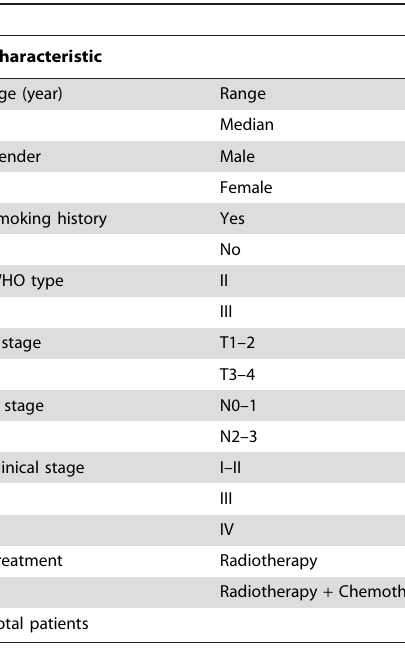
Table 1. Patient